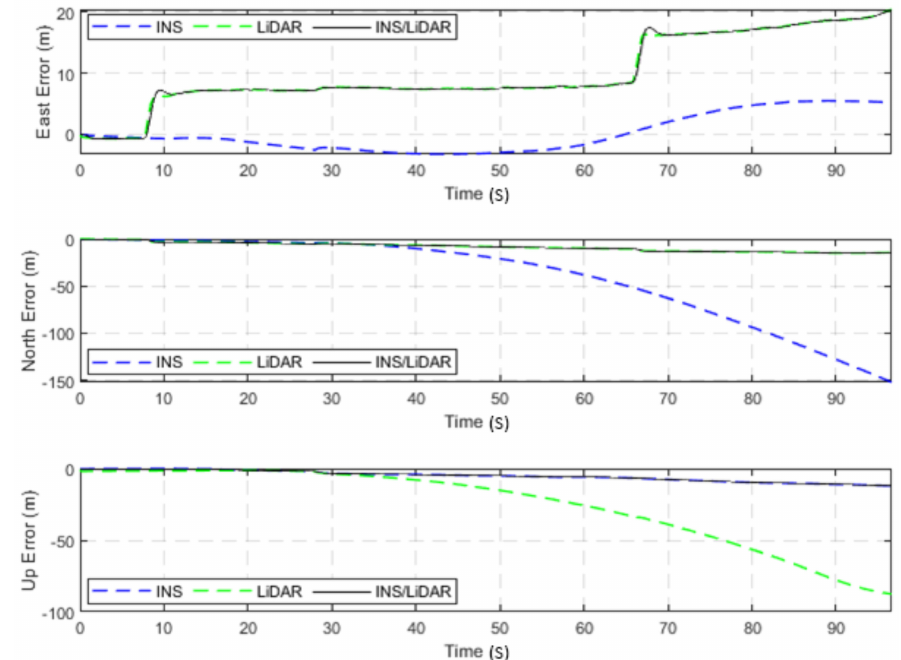
Figure 13. D-101—complete GNSS signal outage: position errors (ENU).